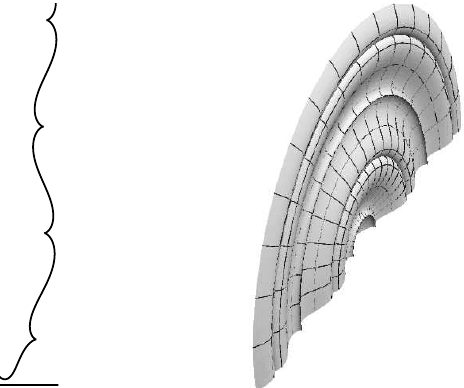
Figure 4 - Generating curve and the surface of revolution of Example